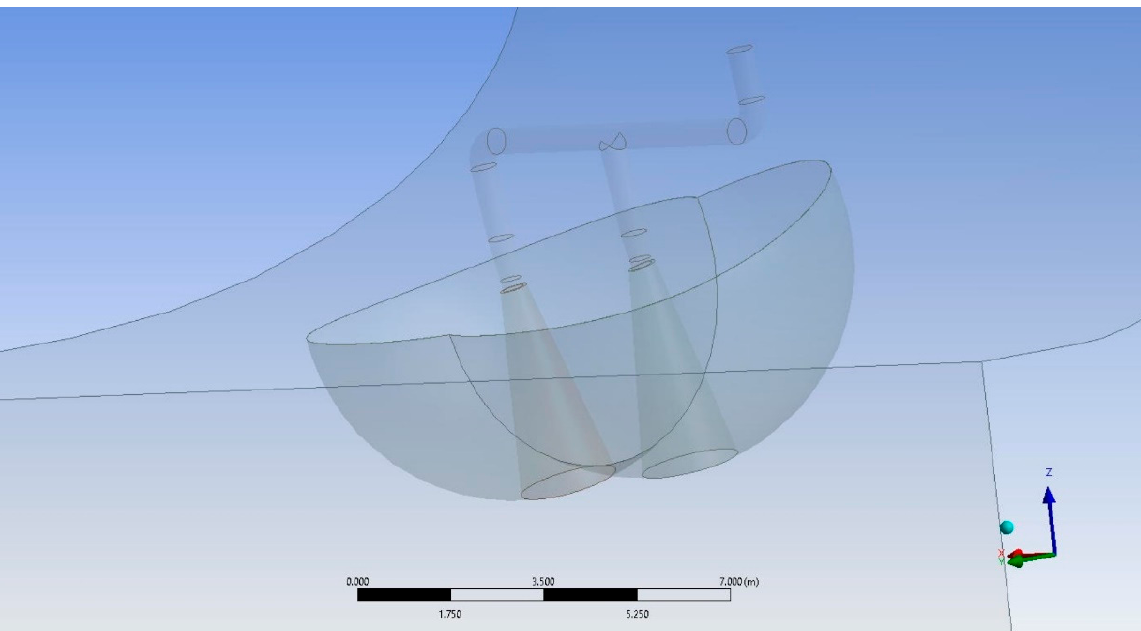
Figure 2. Shell penetration plan for scrubber outlet. The generated geometry (Figure 1) follows the position and dimensions stated in the construction drawings, available during the retrofit project of the ship which was the sub- ject of certification (Figure 2). The bounding box of the computational domain for scrubber wash water pH model- ling has the following dimensions: Height = 20 m, Width = 35 m, Length = 60 m. The origin of the coordinate system is located on the ship hull surface, the Ox axis positive toward fore, the Oy axis positive toward portside, and the Oz axis positive up- wards [17]. For boundaries definition, the details identified in the initial setup geometry are as shown in Figure 3.